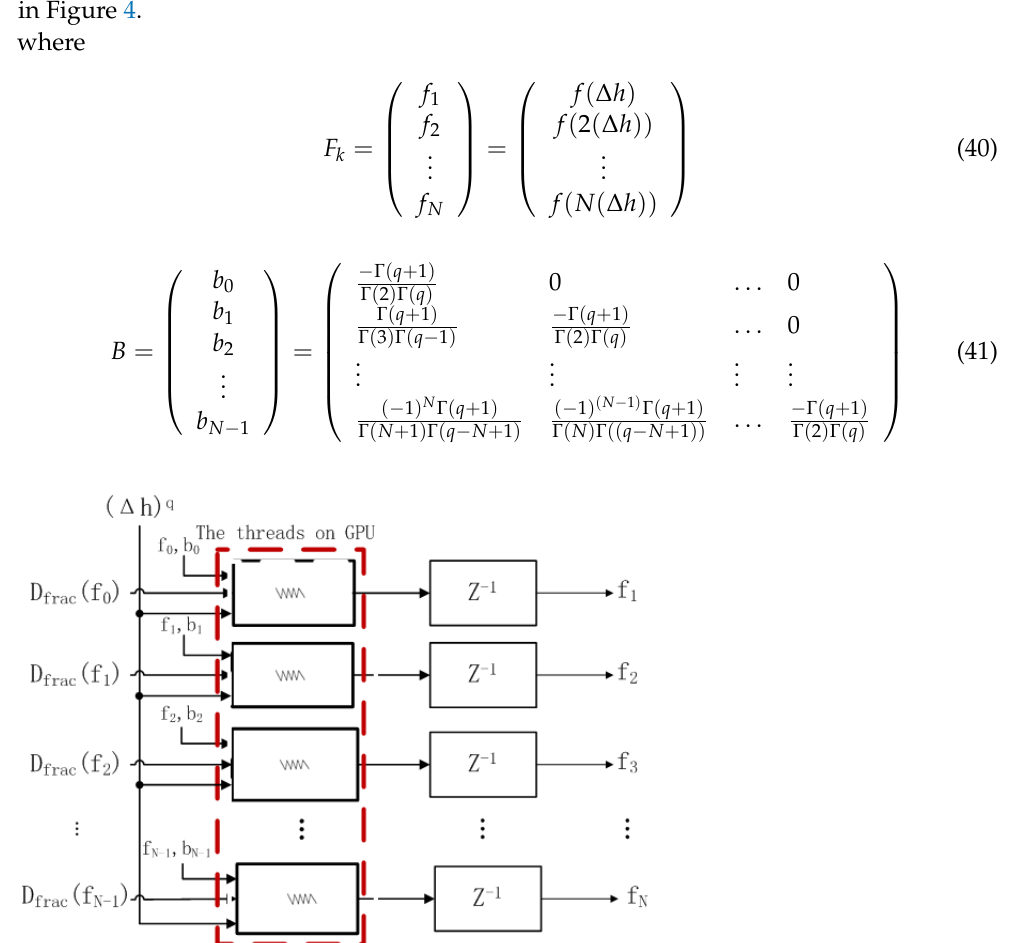
Figure 4. The thread blocks of the proposed parallel